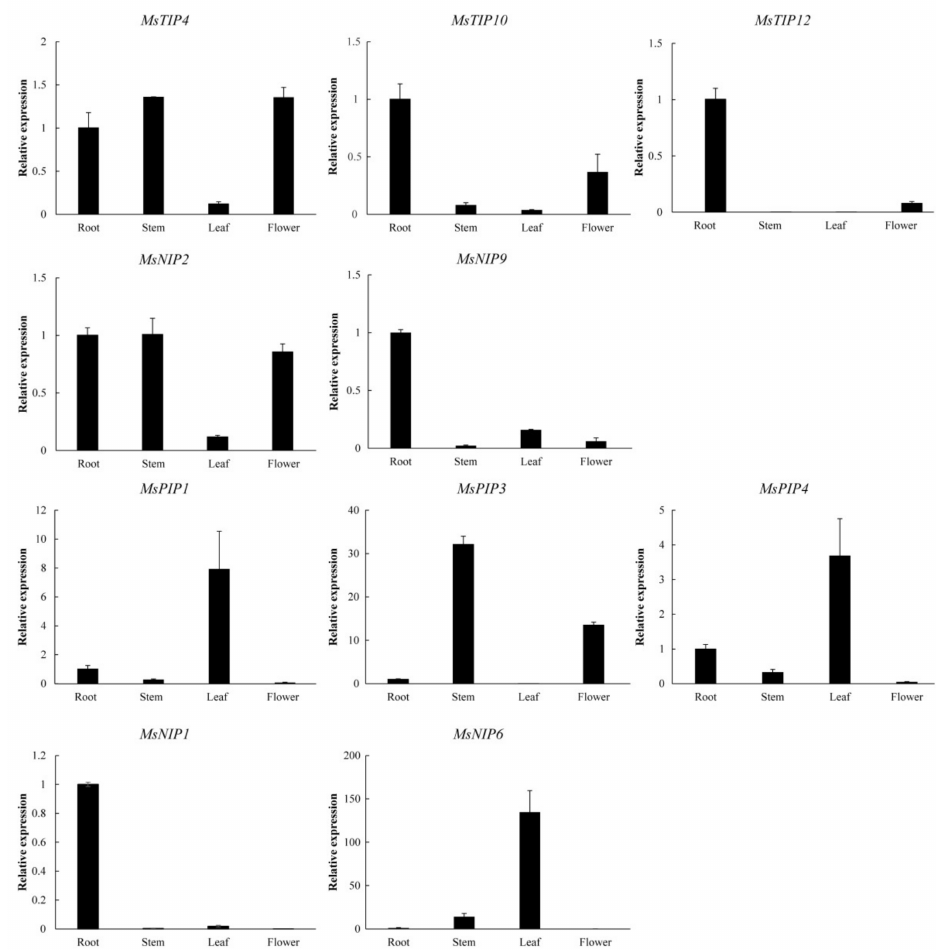
Figure 7. Determination of relative expression levels for 10 MsAQP genes in different tissues in M. sativa by using qPCR. Data are the average of three independent biological samples ± SE and vertical bars indicate standard deviation. The value of the X axis represents root, stem, leaf, flower tissues. The expression level in root for each sample were set as value of